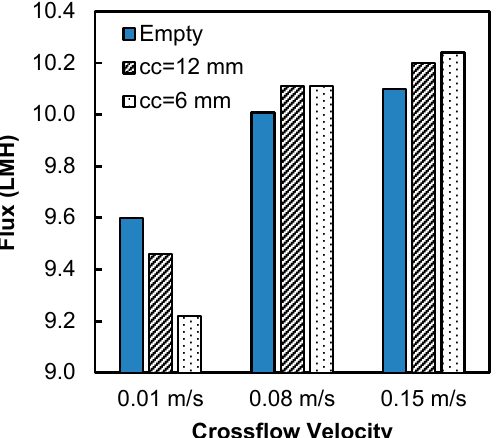
Figure 4. Water flux for empty and spacer-filled channels with spacers having center-to-center (cc) filament distances of 6 mm and 12 mm.